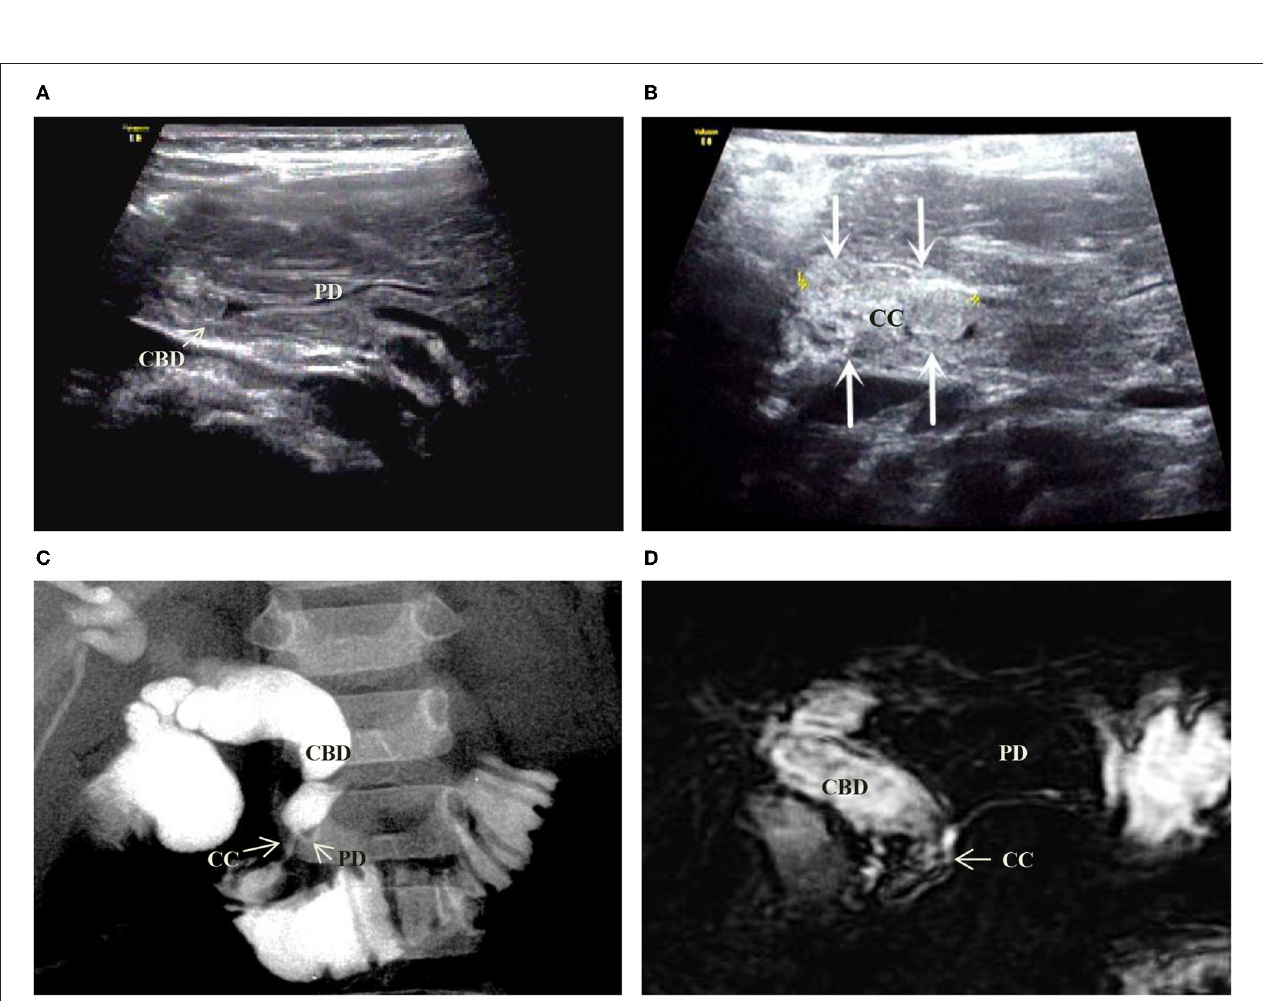
FIGURE 2 | Images of a representative type B of PBM. (A) US transverse scan showed the PD (longitudinal section) joining the CBD which contains the protein plugs. (B) US oblique scan showed the common channel (between the arrows) is dilated and filled with protein plugs. (C) IOC indicated the PD and the dilated CBD joining at a right angle to form a common channel which inserts into the duodenum. (D) MRCP indicated the same features of PD and CBD as that in US and IOC. No significant narrowness in the distal CBD.